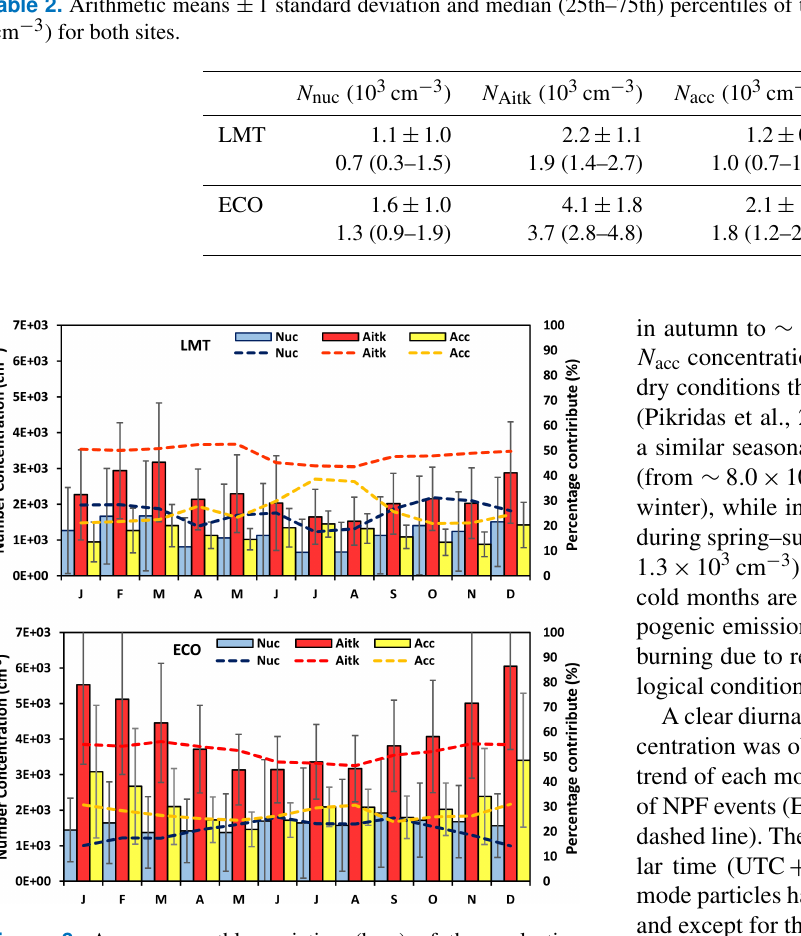
Figure 3. Average monthly variation (bars) of the nucleation, Aitken, and accumulation mode particle number concentrations over the whole period of study at LMT and ECO. The dashed lines represent the monthly percentage contribution of each particle frac- tion to total particle number